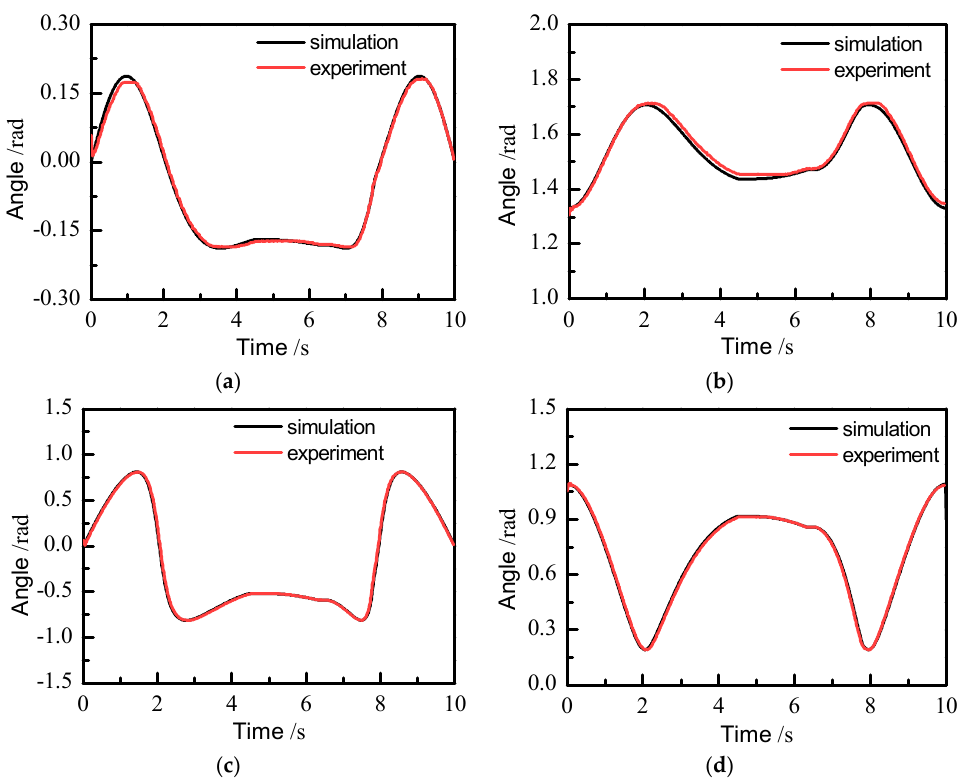
Figure 18. Comparison between the experimental and simulation results of each joint motor: ( a ) output angle of joint 1, ( b ) output angle of joint 2, ( c ) output angle of joint 4, ( d ) output angle of joint 5.